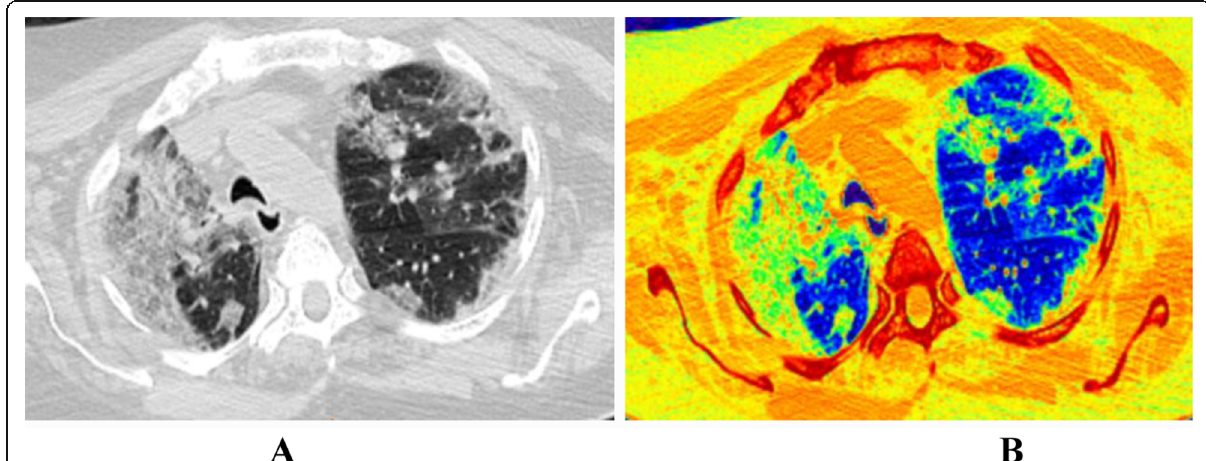
Fig. 1 A 55-year-old female patient with first presentation with dyspnea and cough; CT-SSS was 14. Follow-up revealed development of post- COVID syndrome in the form of persistent cough after 60 days from the onset. a MDCT chest, axial cuts show widespread bilateral predominantly peripheral patchy and confluent ground glass opacities with septal and vascular thickening. b Corresponding color coded images